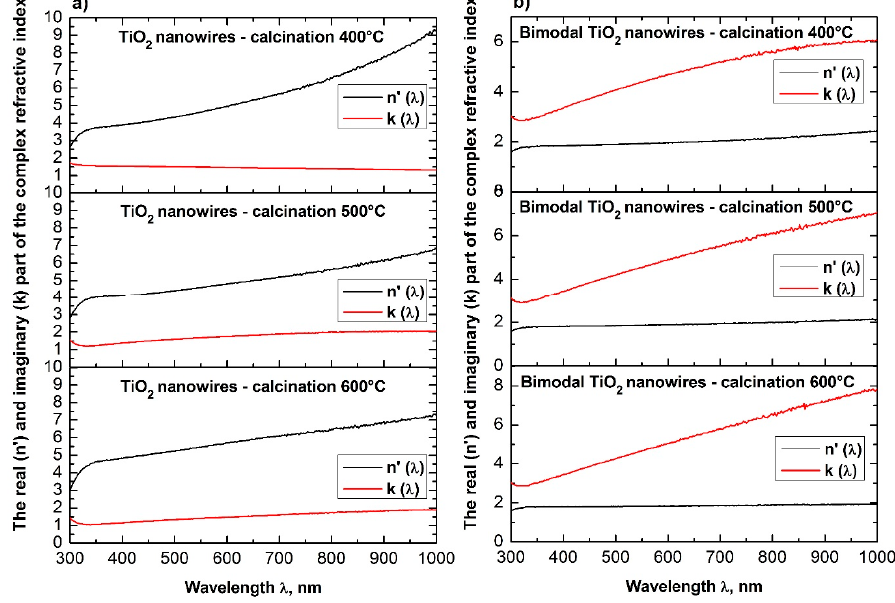
Figure 13. Dependences on the real n ′ ( λ ) ( a ) and imaginary k ( λ ) parts ( b ) of the refractive index